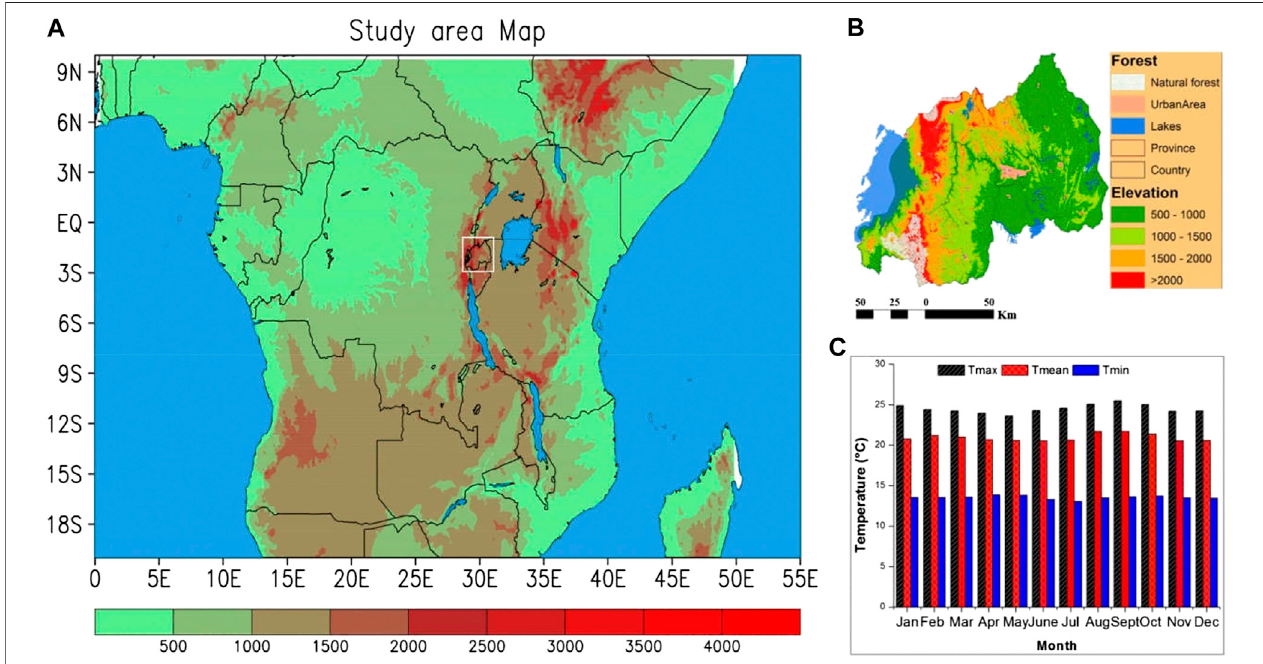
FIGURE 1 | Study area: (A) Location of Rwanda in Middle Africa, (B) Topography of Rwanda, (C) Climatological monthly means of Tmax, Tmean and Tmin over Rwanda during 1961 – 2014.